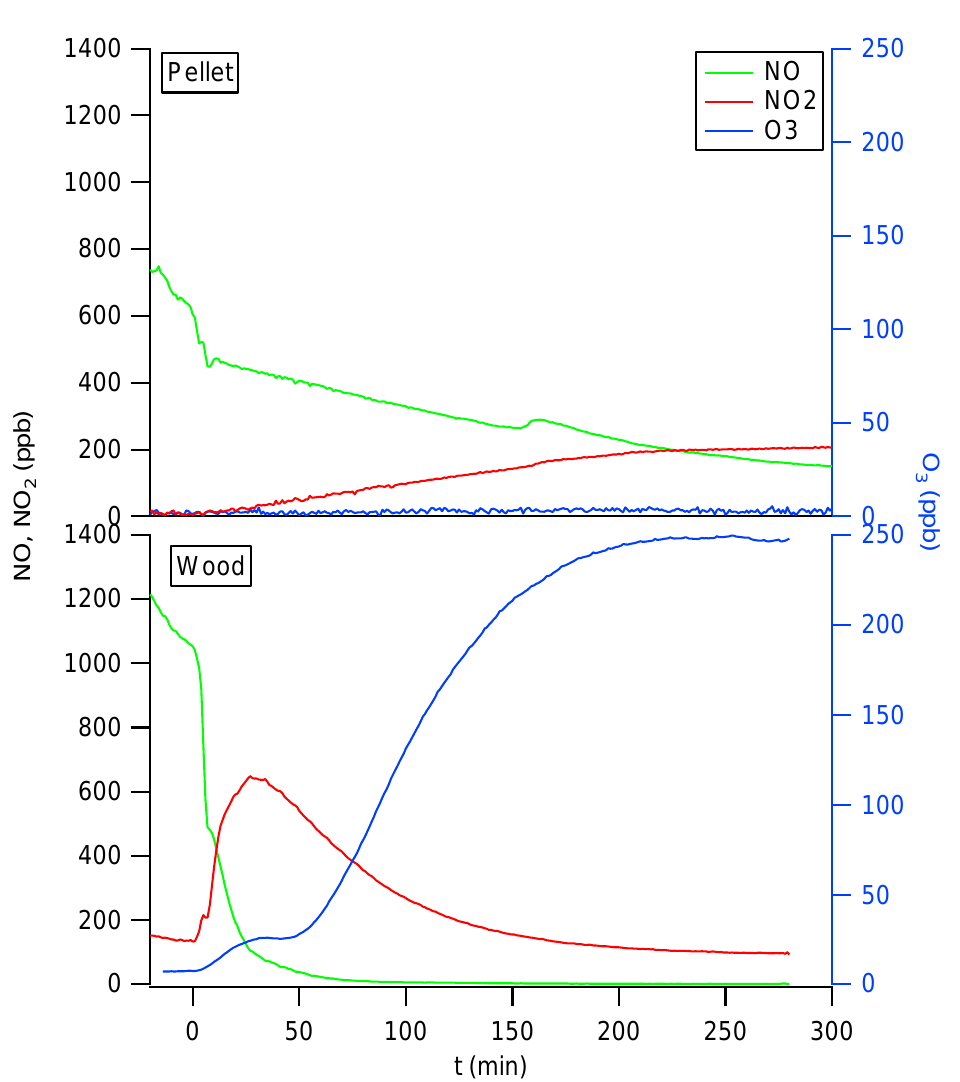
Figure 2. NO, NO 2 , and O 3 concentrations and irradiation time in the firewood and pellet experiments (UV irradiation of filtered emissions).